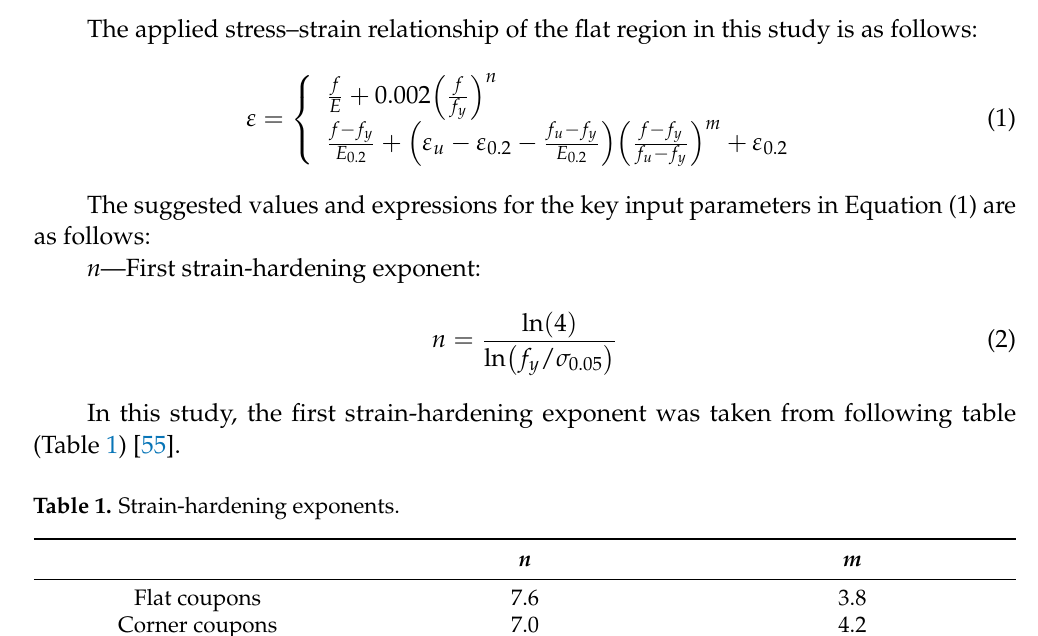
Table 1. Strain-hardening exponents.